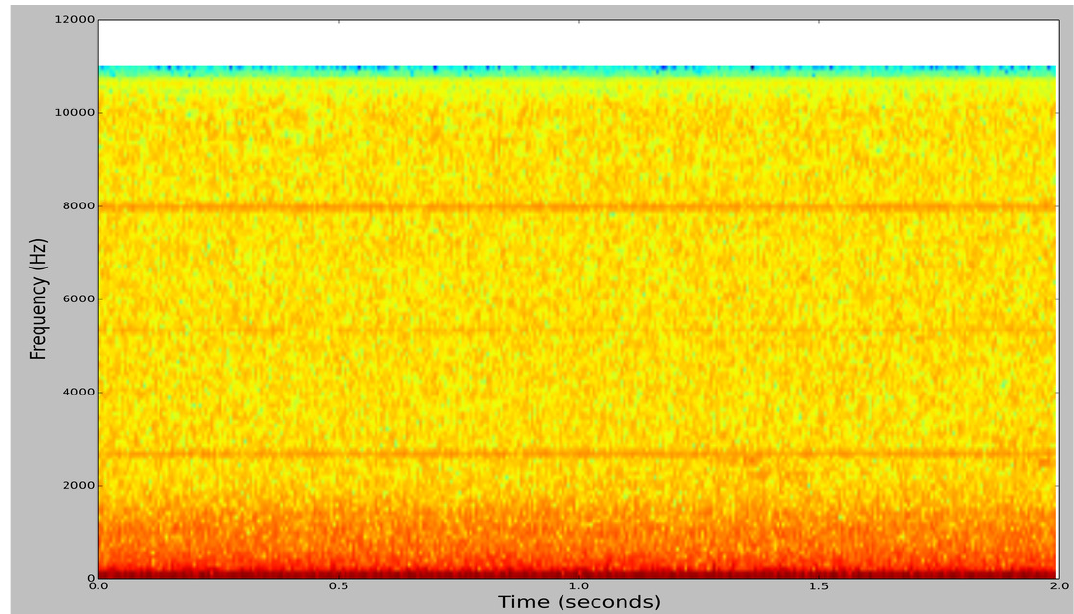
Figure 3. Spectrogram image of a cricket chirping audio sample from BUZZ1.